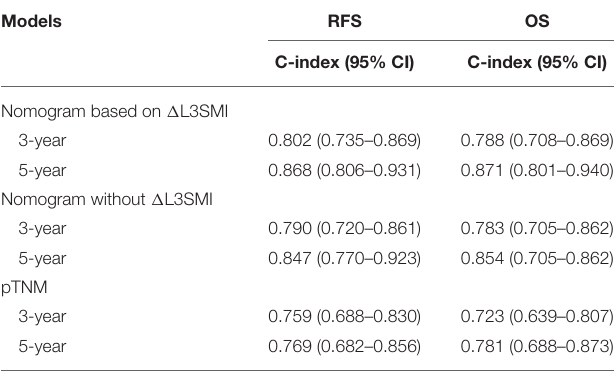
L3SMI: skeletal muscle index at the third lumbar vertebra